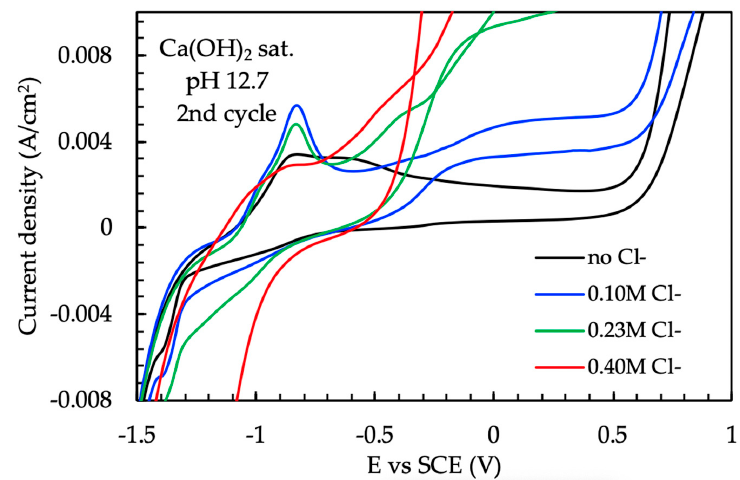
Figure 8. Effect of chloride ion concentration on the second cycle of the voltammetric curves of steel in saturated Ca(OH) 2 solution at pH 12.7 and tartrate ions in a concentration of 1 M. Increasing the pH of the solution at 13.2, the inhibition effect of the tartrate ions is more pronounced: the E 1,1st remains over the potential E ox for all the chloride concentrations used, until a chloride ion concentration of 3 M is reached (Figure 9). In the presence of a chloride ion concentration of 3.5 M, the value of E 1,1st reached the E ox , but the presence of hysteresis in the return scan of potential evidenced the initiation of localized attack during the oxygen evolution. Oxygen evolution causes the acidification of the electrode surface favoring the pitting initiation [70]. The second cycle of the voltammetric curves confirms the absence of localized attack initiation for chloride concentration lower than 3 M (Figure 10).